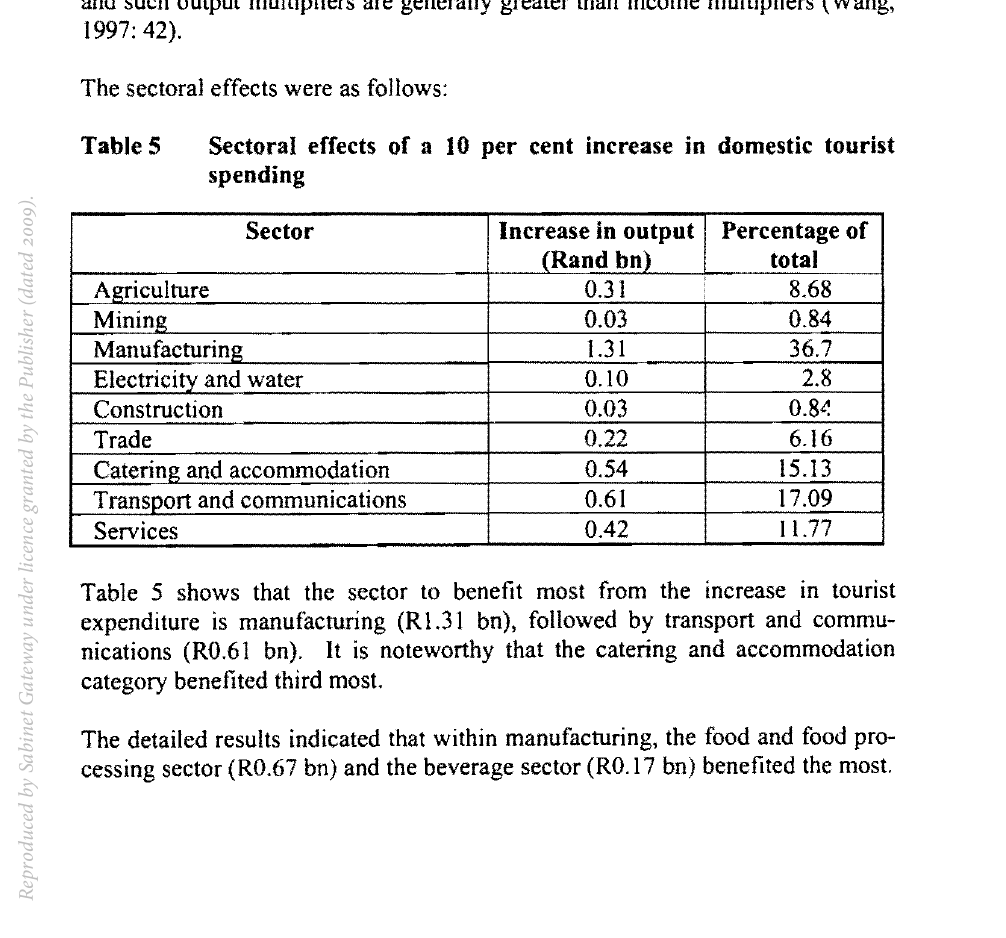
Sectoral effects of a 10 per cent increase in domestic